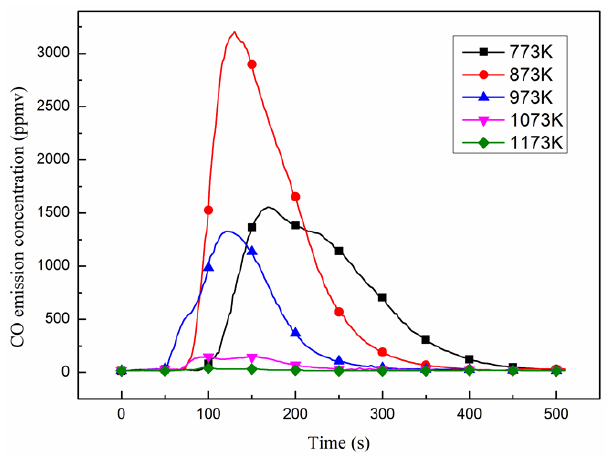
Figure 2. The e ff ect of combustion temperature on CO Figure 2. The effect of combustion temperature on CO emission.